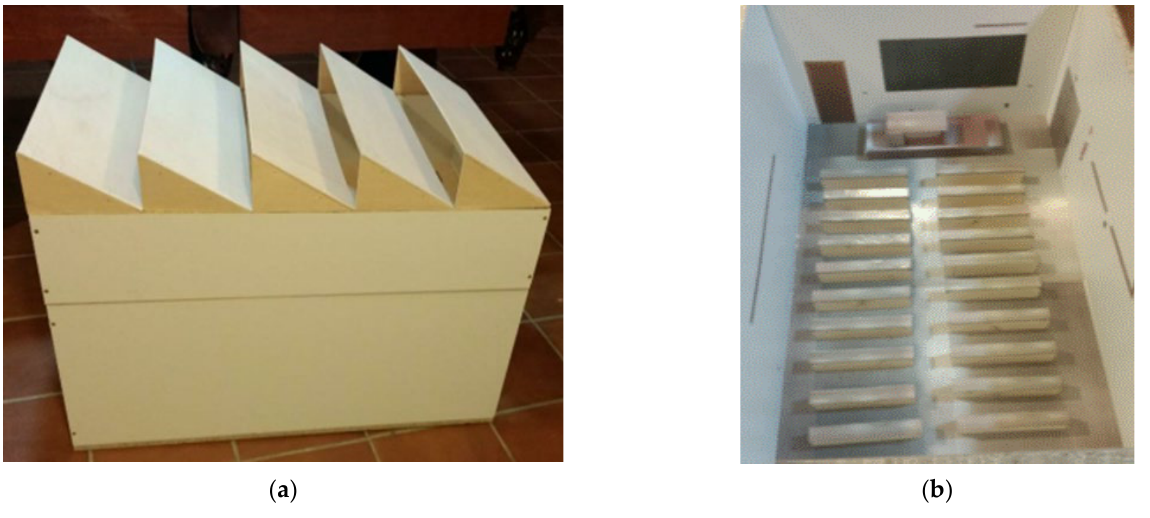
Figure 6. Scale model of the classroom of the Leonardo da Vinci building of the Rabanales University Campus of the University of Córdoba (Spain): ( a ) exterior; ( b ) inside.